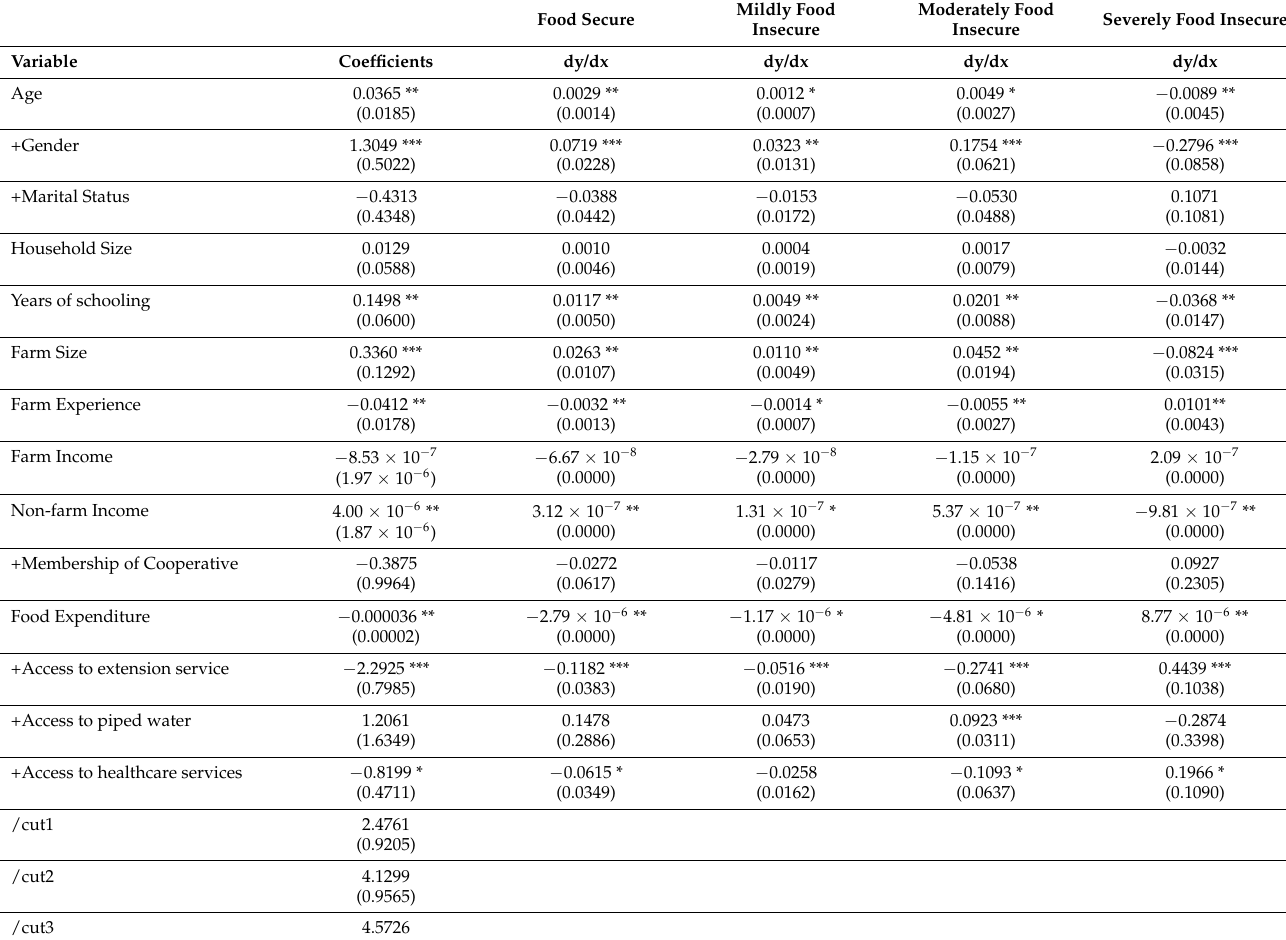
Table 9. Drivers of household food